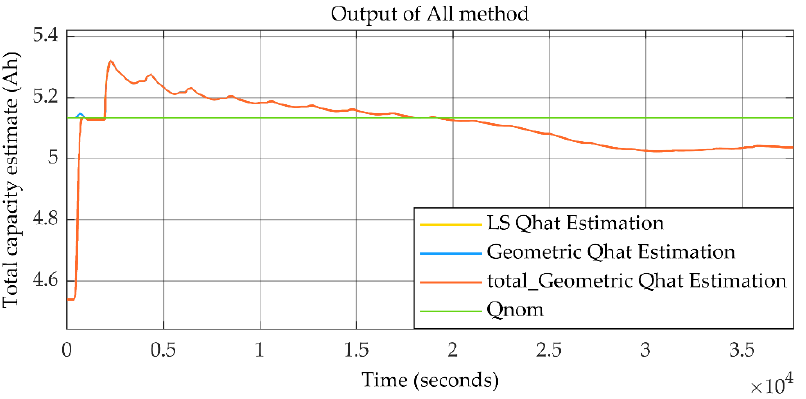
Figure 10. Comparison of different methods.